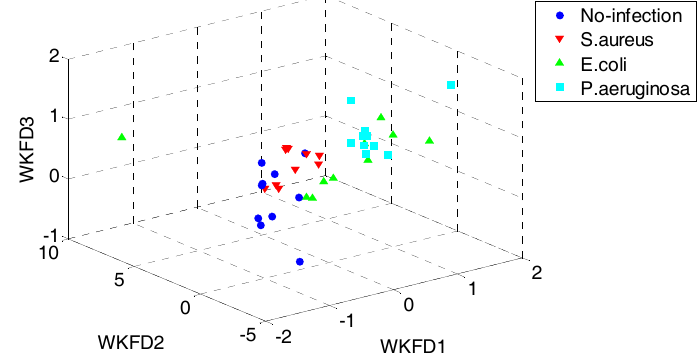
Figure 5. Score plots of QWKFDA.